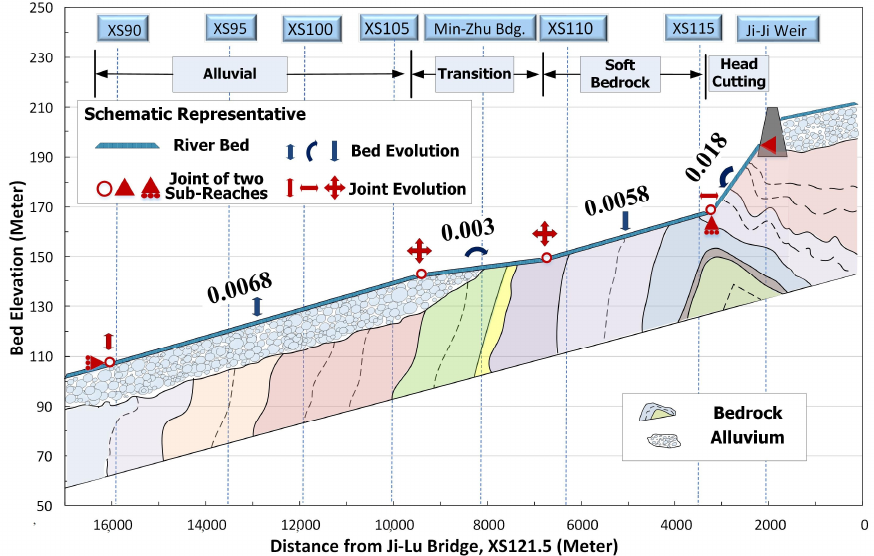
Figure 11. Schematic sketch of the transient stable channel slope evolution for the four sub-reaches of the study site.